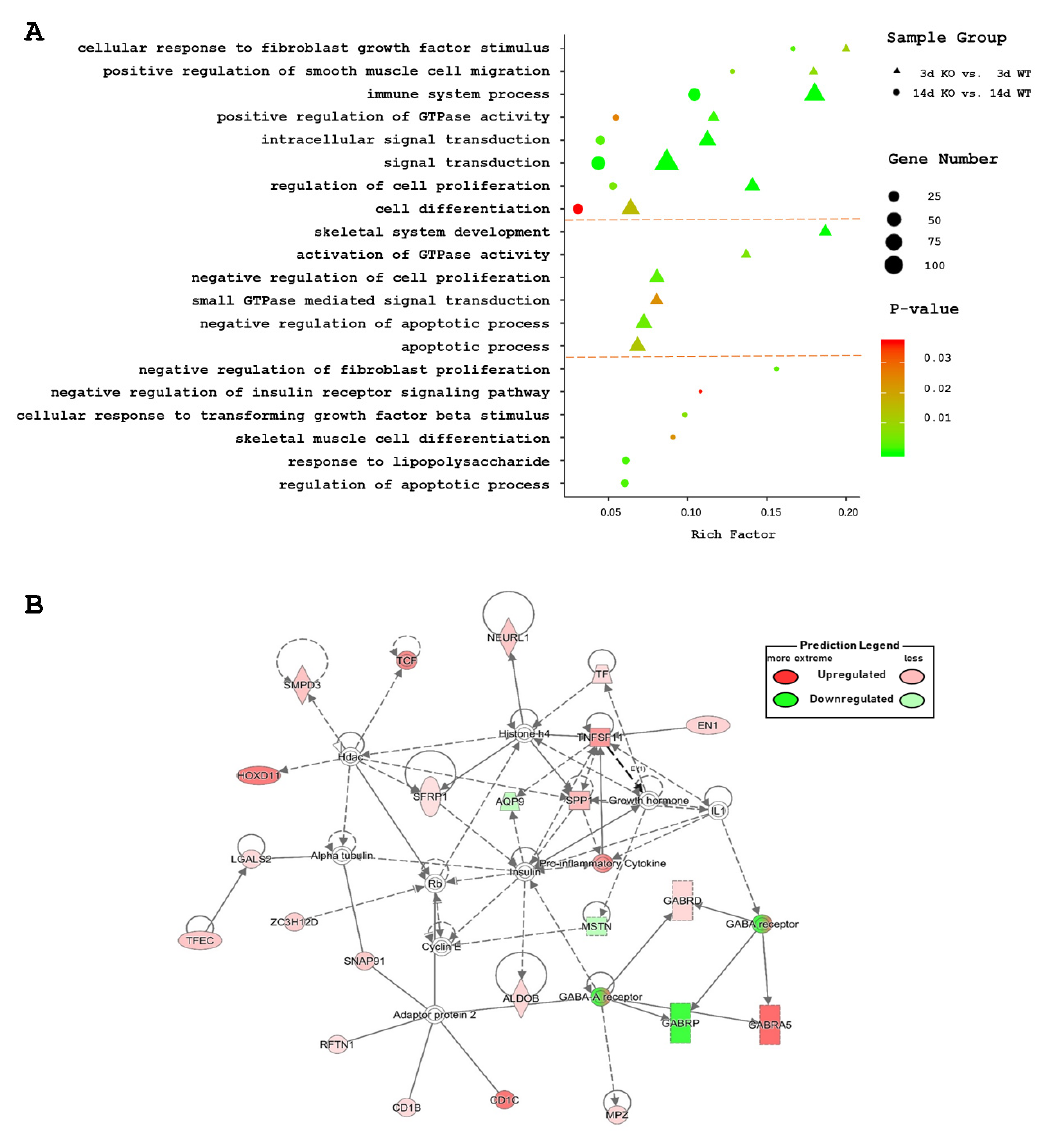
Figure 3. Representative enriched gene ontology functional classifications and associated network of differential expression genes (DEGs) between MSTN knockout (KO) and wild-type (WT) muscles. ( A ) Representative gene ontology (GO) enrichment terms of DEGs in the 3d KO vs. 3d WT groups and 14d KO vs. 14d WT groups. ( B ) Gene network containing DEGs related to Neurological Disease, Organismal Injury and Abnormalities, and Skeletal and Muscular Disorders. This result also has some limitations, because the KO groups were injected with AdV-CRISPR, while the WT groups were injected with PBS.